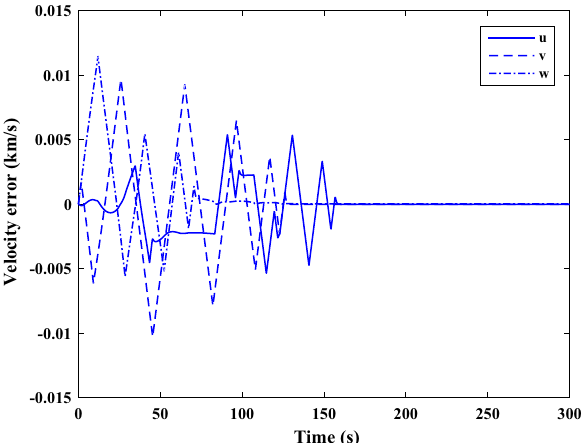
Figure 25. Scenario I: relative linear velocity error (in chaser body frame).